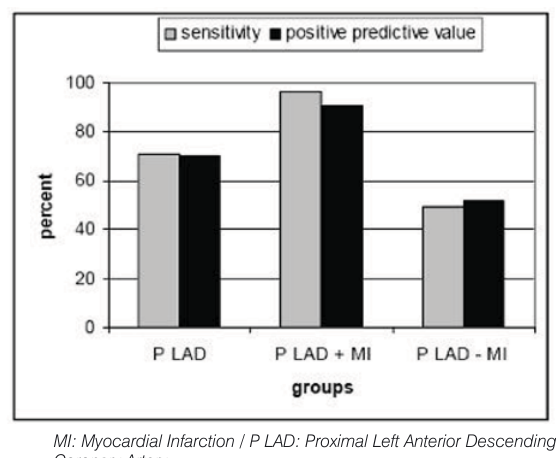
Figure 1. Sensitivity & positive predictive value of inverted U wave in differnet